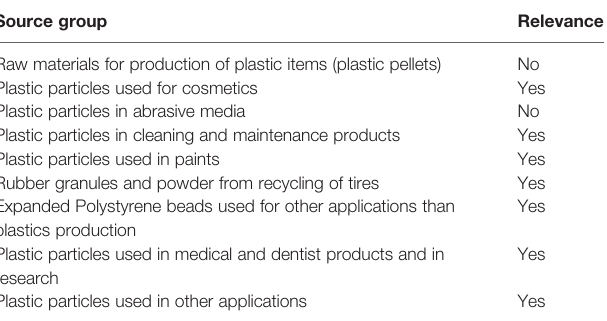
TABLE 1 | Generic primary MP sources, modi fi ed from (Lassen et al., 2015) and indicating relevance to cruise ships. Source group